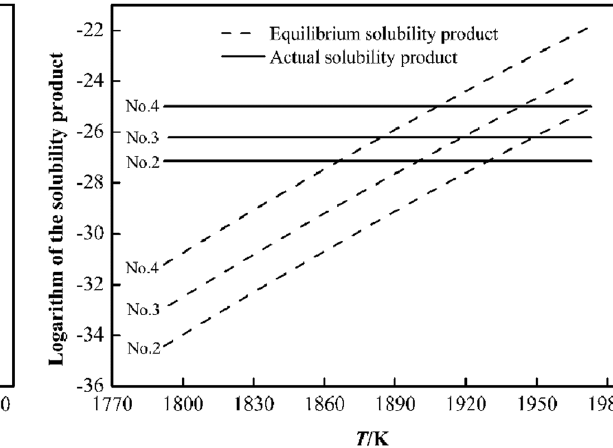
Figure 5: Logarithm of the solubility product as a function of temperature for Y 2 O 2 S in the liquid steel.